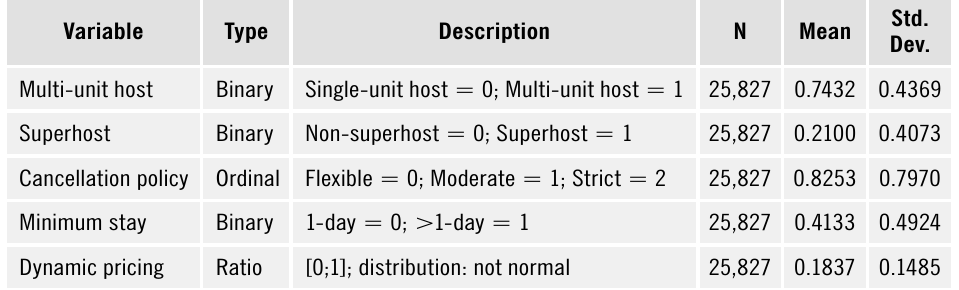
Table 5. Variables’ summary and basic